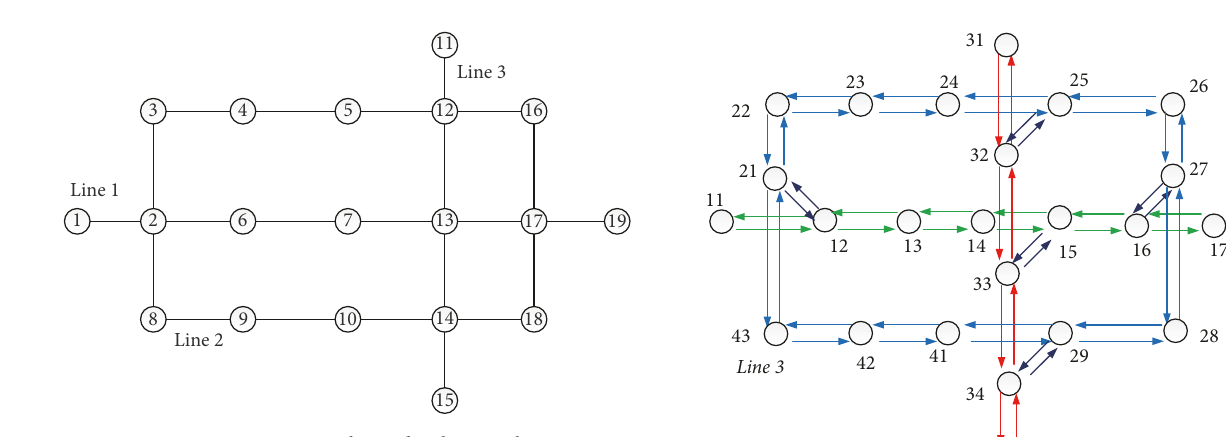
Figure 3: A practical tested rail network.